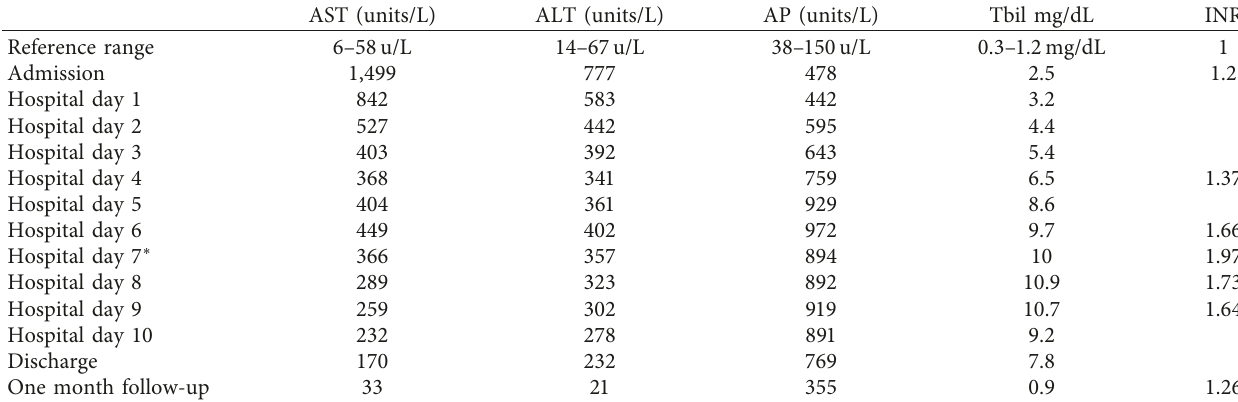
Table 1: Patient LTs and INR over the course of